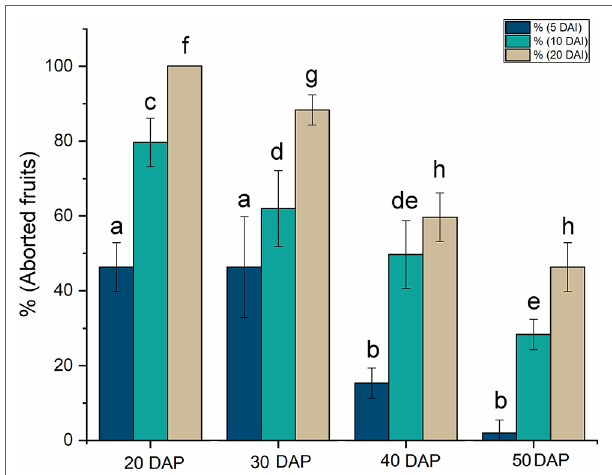
FIGURE 1 | Effect of the stage of development on the rate of fruit abortion caused by the injection of Agrobacterium . The stage is expressed as days after pollination (DAP) and the abortion rates at 5, 10, and 20 days after injection (DAI) are shown. The data are the average of up to 10 injections ± the standard deviation. Letters indicate statistically significant differences (one-way ANOVA 0.05% significance level) when comparing aborted seeds at same DAI between seeds at different DAP.